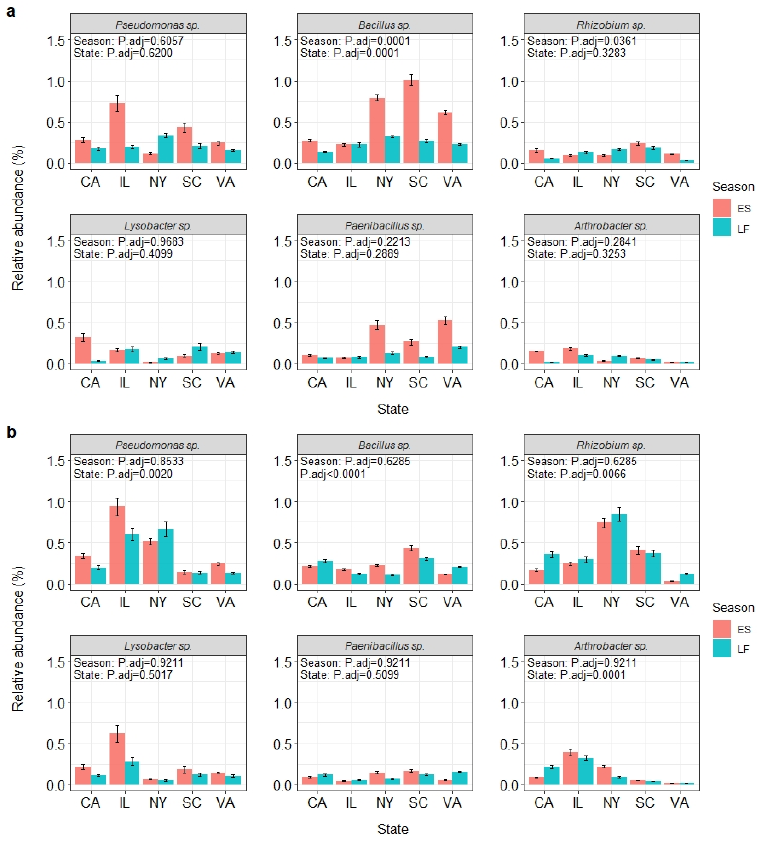
Figure 4. Kruskal–Wallis test on the relative abundance of the six most abundant bacterial BCA candidate species found from the California (CA), Illinois (IL), New York (NY), South Carolina (SC), and Virginia (VA) samples collected in early summer (ES) and late fall (LF) of 2017 ( a ) and 2018 ( b ).